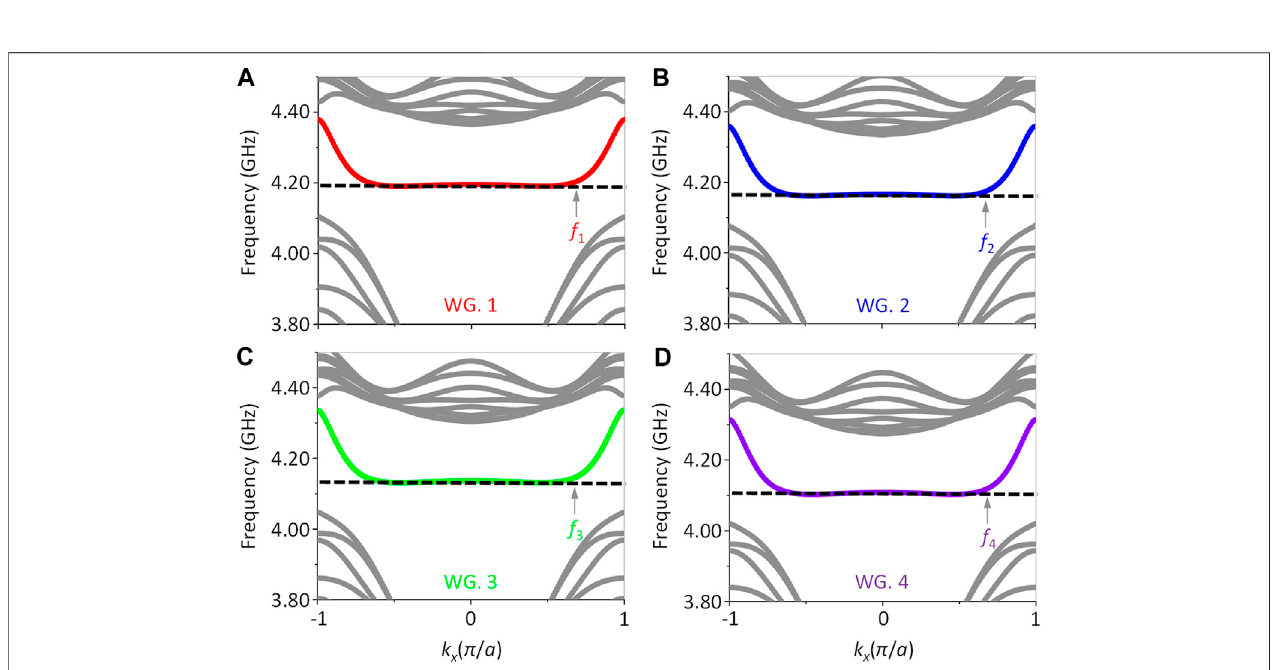
FIGURE 4 | Projected band structure of the GPC waveguide segment. (A) WG. 1: r 1 (cid:1) 4.35 mm, d 1 (cid:1) 57.75 mm, and f 1 (cid:1) 4.1902 GHz. (B) WG. 2: r 2 (cid:1) 4.40 mm, d 2 (cid:1) 58.10 mm, and f 2 (cid:1) 4.1614 GHz. (C) WG.3: r 3 (cid:1) 4.45 mm, d 3 (cid:1) 58.55 mm, and f 3 (cid:1) 4.1314 GHz. (D) WG. 4: r 4 (cid:1) 4.45 mm, d 4 (cid:1) 58.90 mm, and f 4 (cid:1) 4.1032